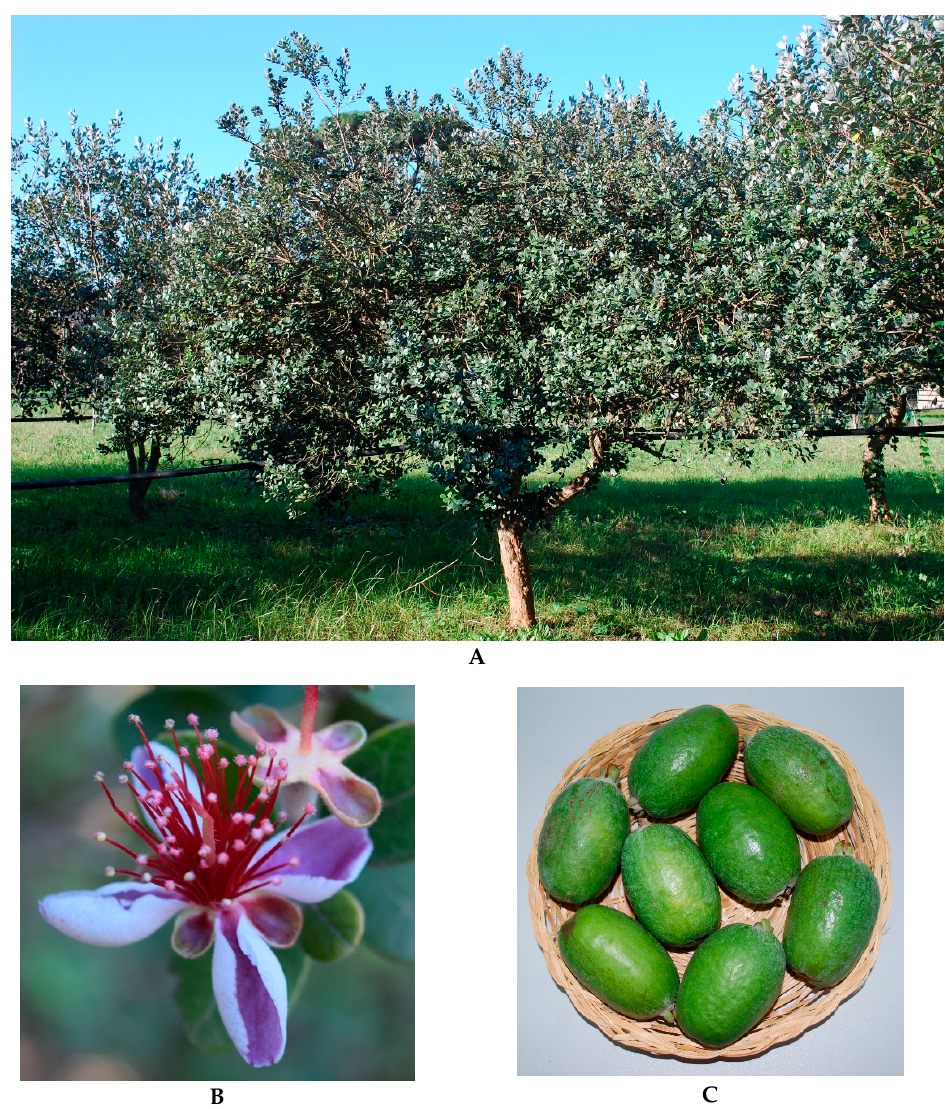
Figure 1. Feijoa experimental orchard located in Caserta, Southern Italy (41°90 ′ N, 14°80 ′ E) and owned by the CREA-OFA (Italy) ( A ), flower ( B ), and fruits cv Mammouth ( C ).